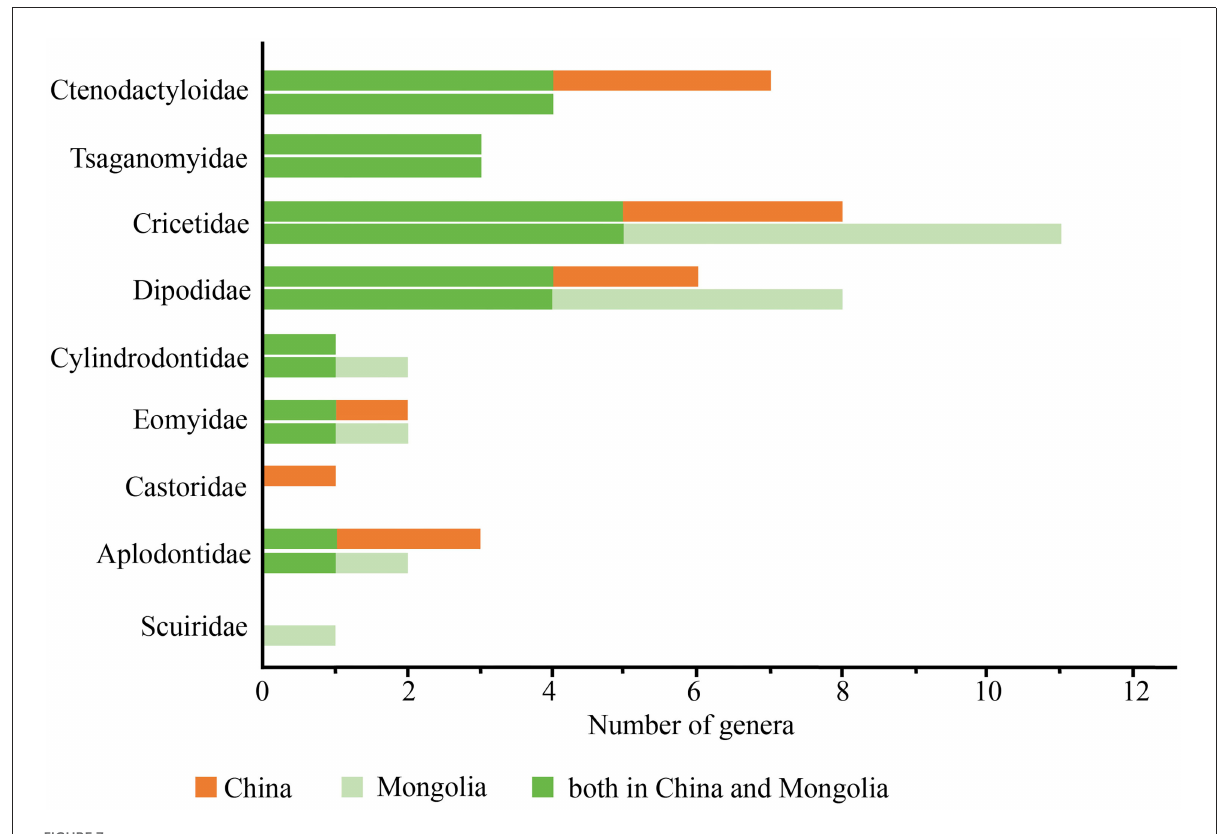
FIGURE7 Diagrams of the Hsandagolian rodent composition in China and